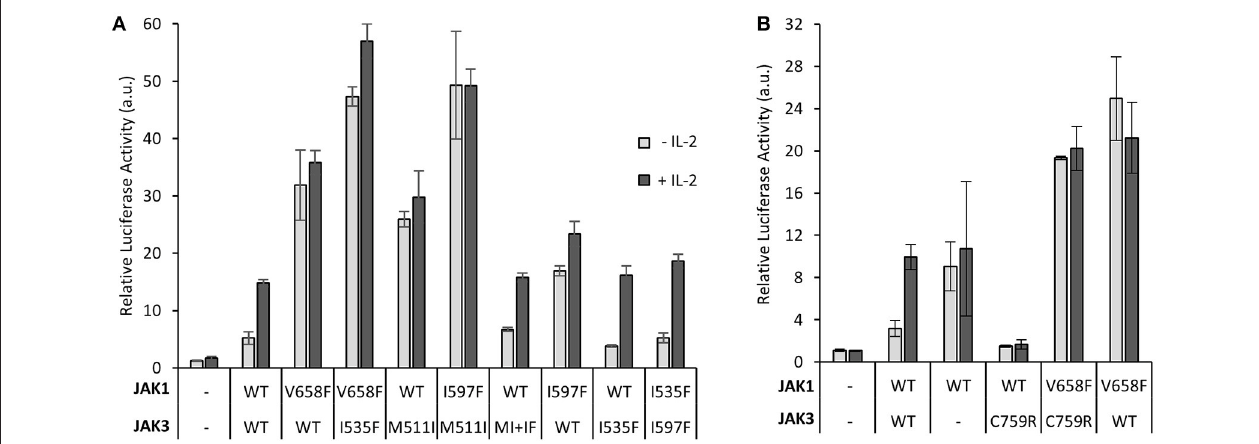
FIGURE 5 | Disrupting the JAK3 JH2 nucleotide binding site inhibits JAK3-induced, but not JAK1-induced, hyperactivation, and vice versa . (A) Constitutive activation of STAT5 caused by oncogenic JAK3 mutations are suppressed only by ATP-binding site mutations in JAK3 and not its dimerization partner JAK1. Luciferase assay of U4C γβ cells transiently transfected with JAK1, JAK3, SPI-luc2 and pRL-TK. Results are average from two separate experiments each with triplicate or duplicate (I597F + I535F and I597F + WT JAK3) samples. The results are normalized to the JAK1 WT and JAK3 WT sample. Error bars show the SD. (B) Inhibitory JAK3 SCID mutation C759R does not reduce oncogenic hyperaction of JAK1-mutant. Luciferase assay in U4C γβ cells transiently transfected with JAK1, JAK3, SPI-luc2, and pRL-TK. Error bars are SD of triplicate samples and the data is representative of three independent experiments. Supplementary Figure 5B shows immunoblotting for protein expression levels.